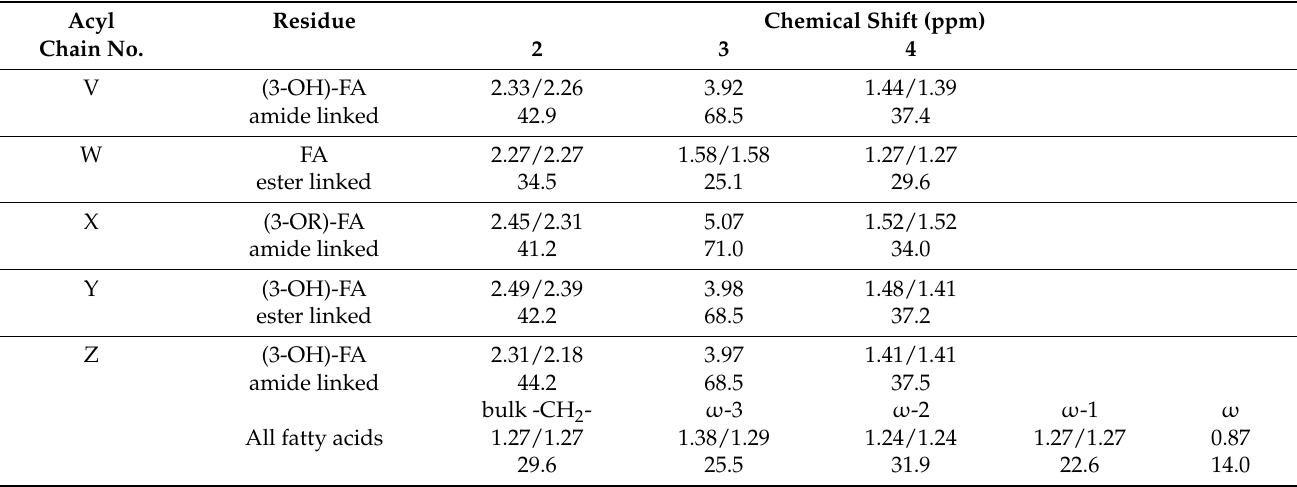
Table 2. NMR assignments of fatty acid substituents in the Ko–lipid A of G. bethesdensis . For NMR spectra, refer to Figures 3 and 4.